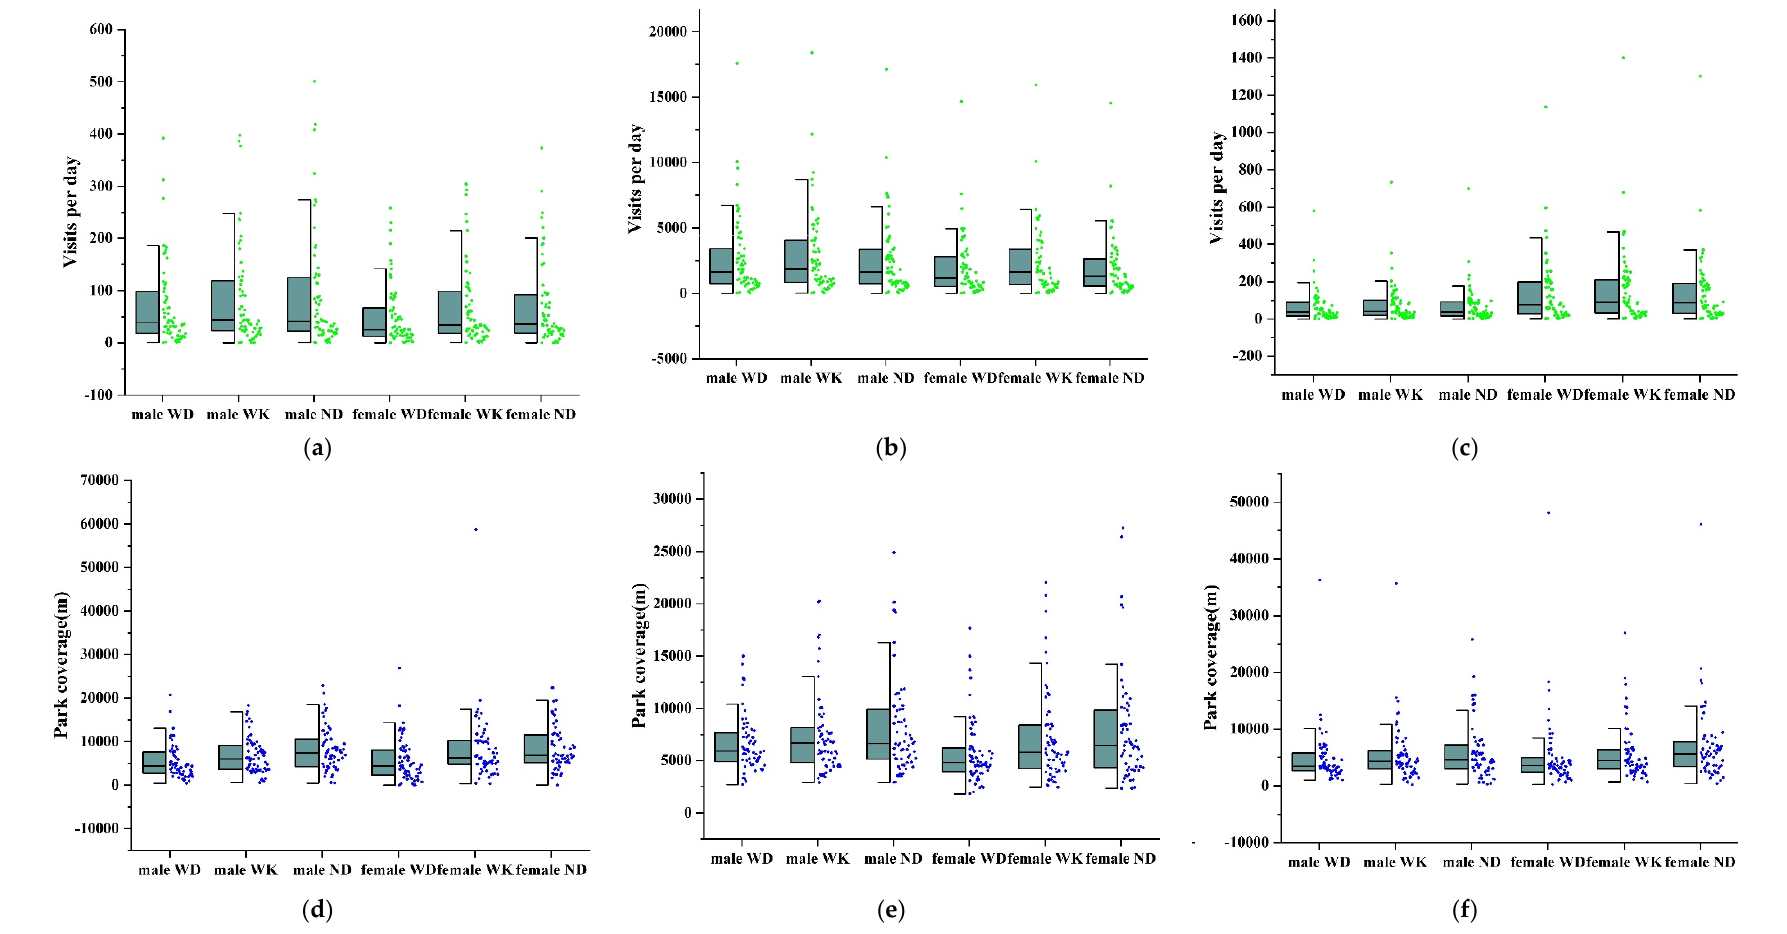
Figure 4. The average daily visits and service radius of different groups in 56 parks on weekdays (WD), weekends (WK), and the National Day holiday (ND). ( a–c ) Number of daily park visits for Groups 1, 2, and 3. ( d–f ) Park service radius for Groups 1, 2, and 3.